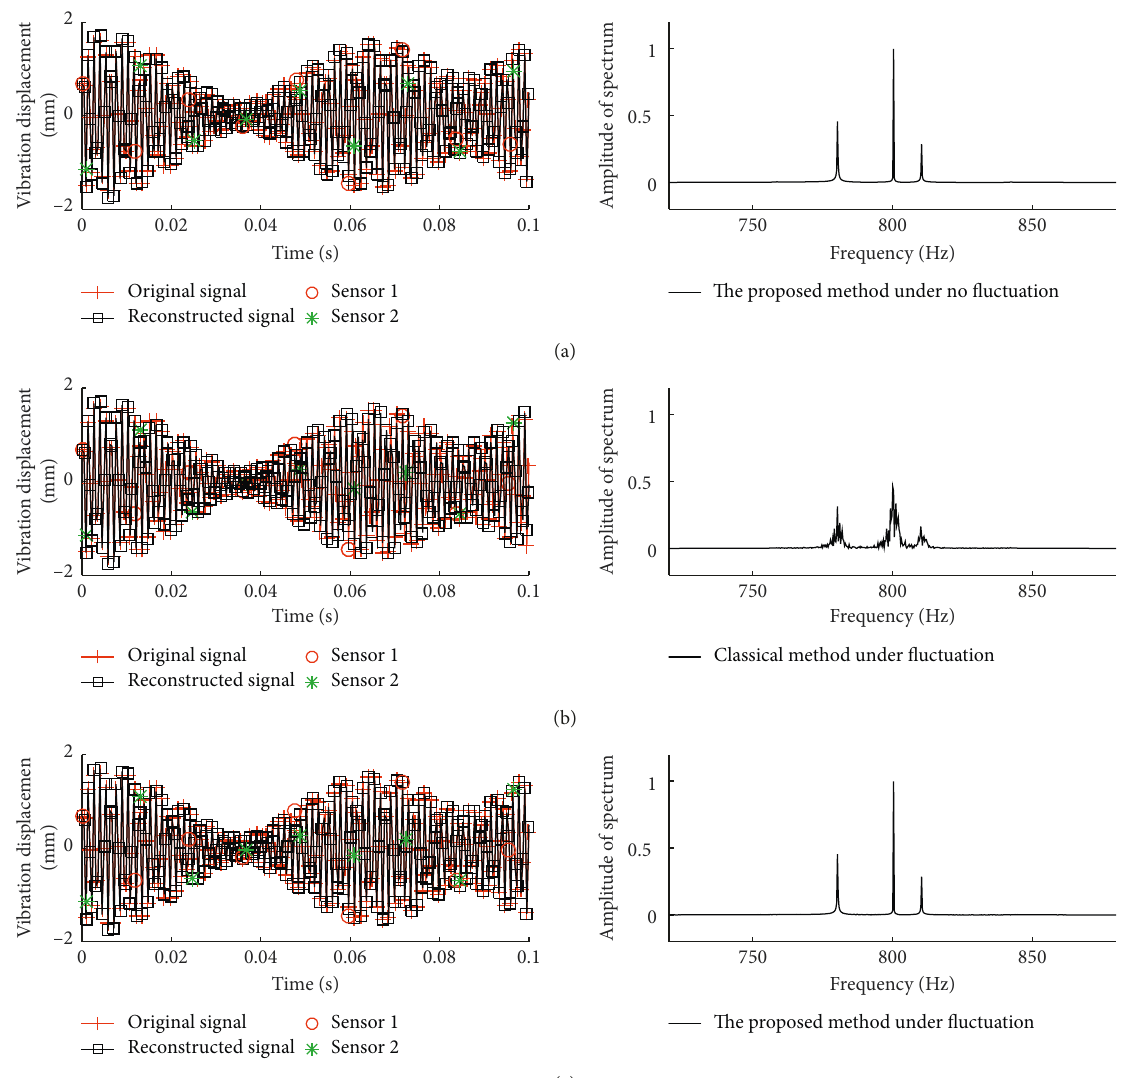
Figure 13: Comparisons of reconstructed vibrations by two